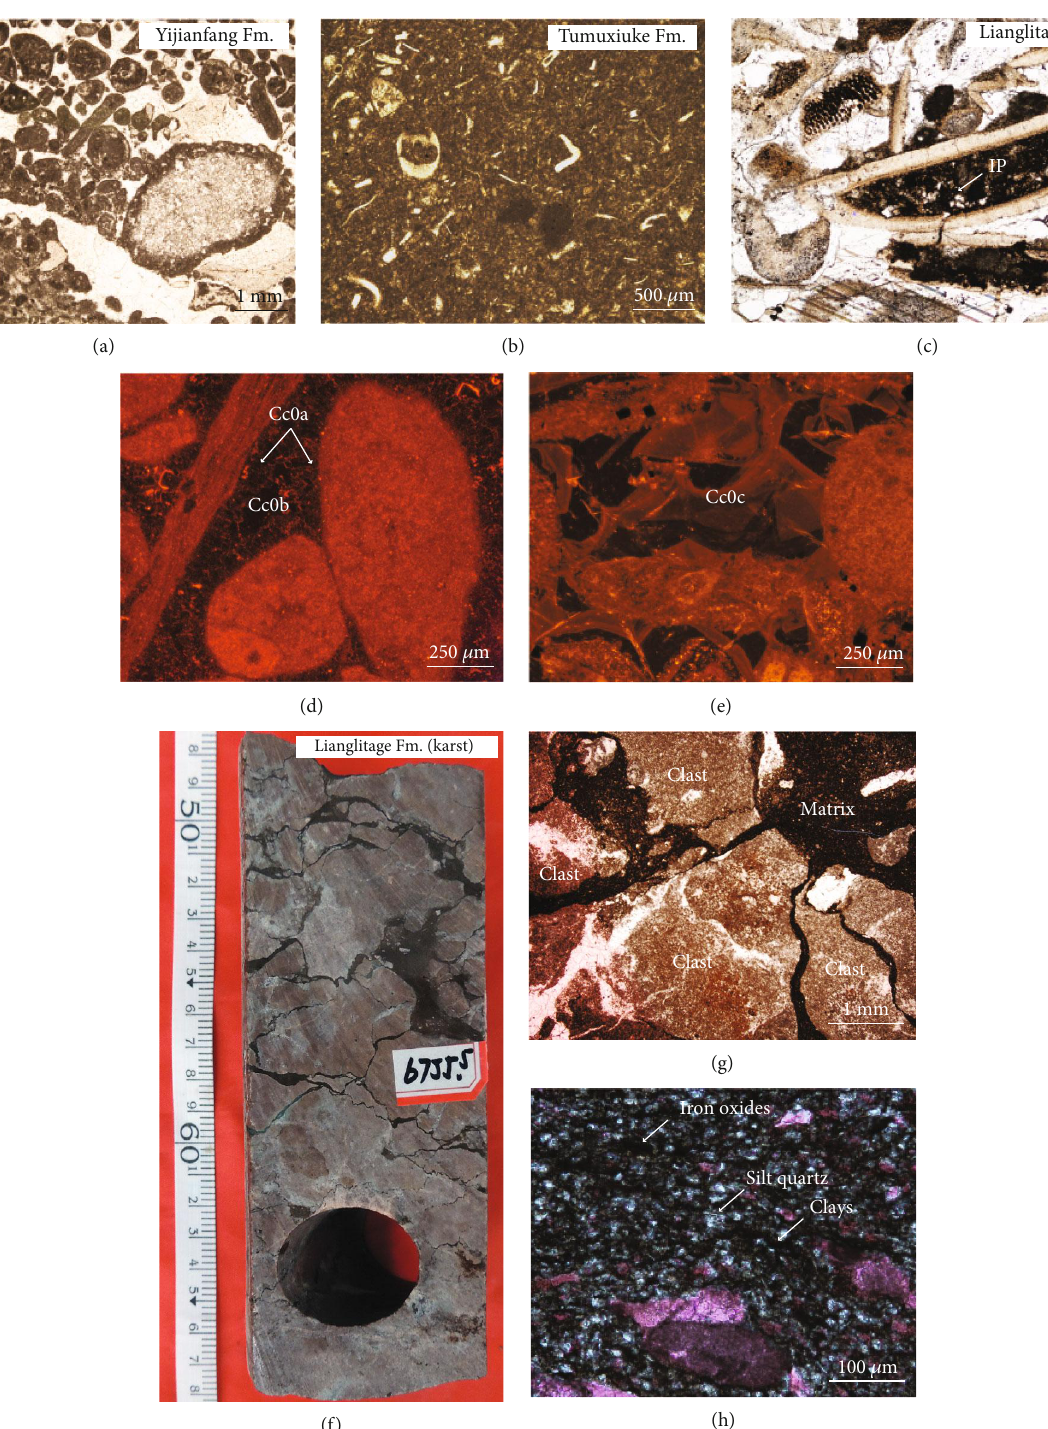
Figure 4: Photomicrographs of Ordovician carbonates. (a) Plane light optical photomicrograph of the Yijianfang Formation, (b) Tumuxiuke Formation, and (c) Lianglitage Formation host rocks. IP=interparticle pores; IX =intercrystalline pores. (d) Optical-CL photomicrograph of grainstone cemented by fi brous to bladed calcite rims (Cc0a) and drusy mosaic (Cc0b) cements. (e) Optical-CL photomicrograph of grainstone cemented by syntaxial cement (Cc0c). (f) Hand specimen of the karstic horizon within the Lianglitage Formation showing matrix-rich, clast-supported chaotic breccia. (g) Plane light optical photomicrograph of angular red clasts in Lianglitage Formation breccias. (h) Close-up photomicrograph of the breccia